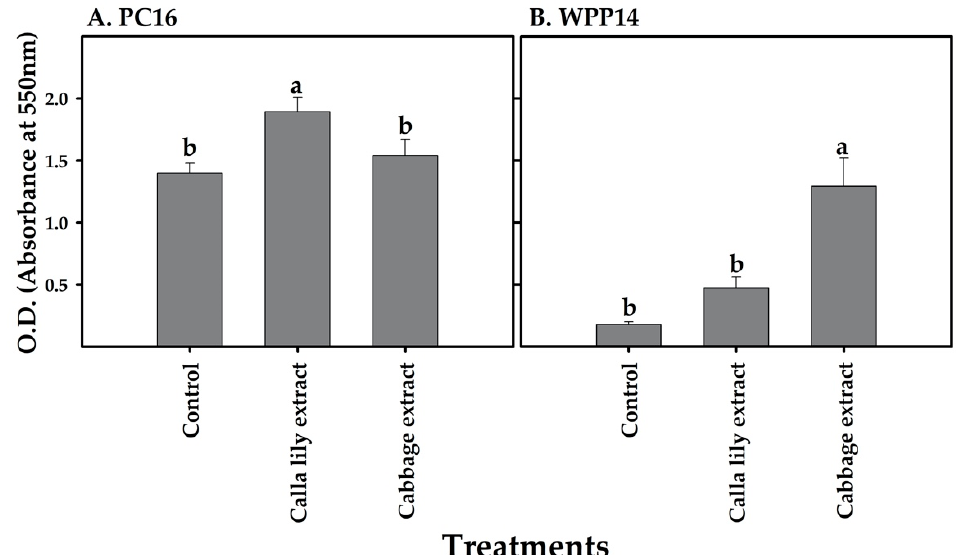
Figure 7. Effect of phenolic extracts from calla lily or cabbage leaves on the biofilm formation ability of Pectobacterium strains ( A ) PC16 and ( B ) WPP14. Biofilms were measured following the exposure of Pectobacterium strains to a non-lethal volume (40 µL extract/200 µL LB) of each host extract (or extraction buffer as control) for 72 h at 28 ° C in glass test tubes. Biofilms were quantified by measuring absorbance at 550 nm (crystal violet bound to biofilm cells). Experiments were repeated twice with six replicates for each experiment. Tukey–Kramer HSD test was used to test the differences, bars not labeled with the same letter (a-b) are significantly different from each other ( p < 0.05; bar = mean ± SE; n = 12).